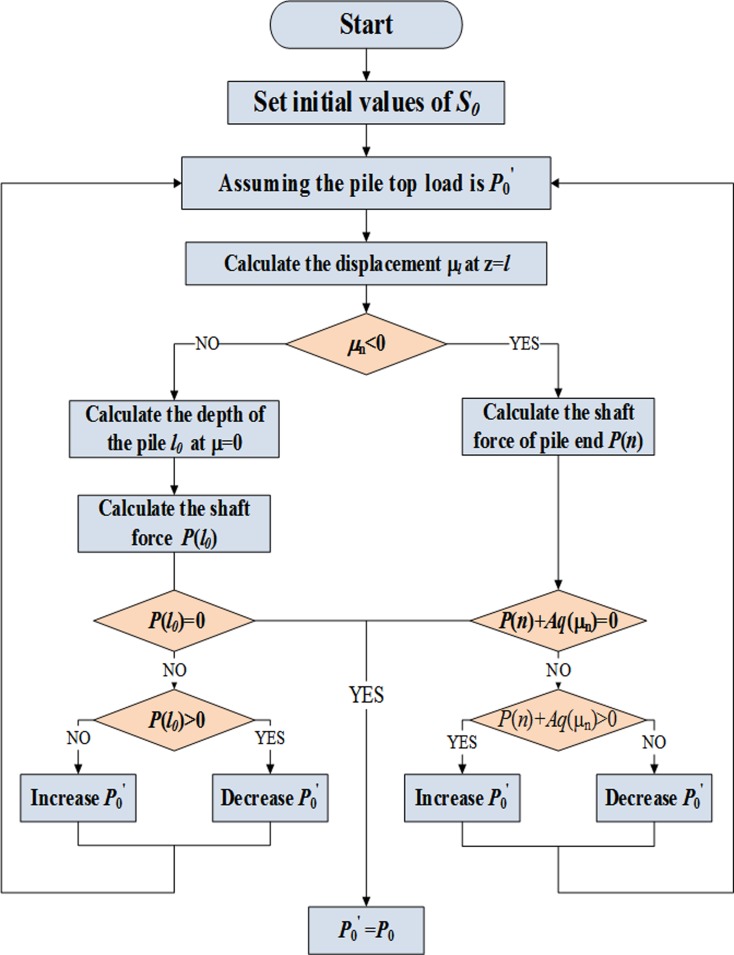
Program flow chart.